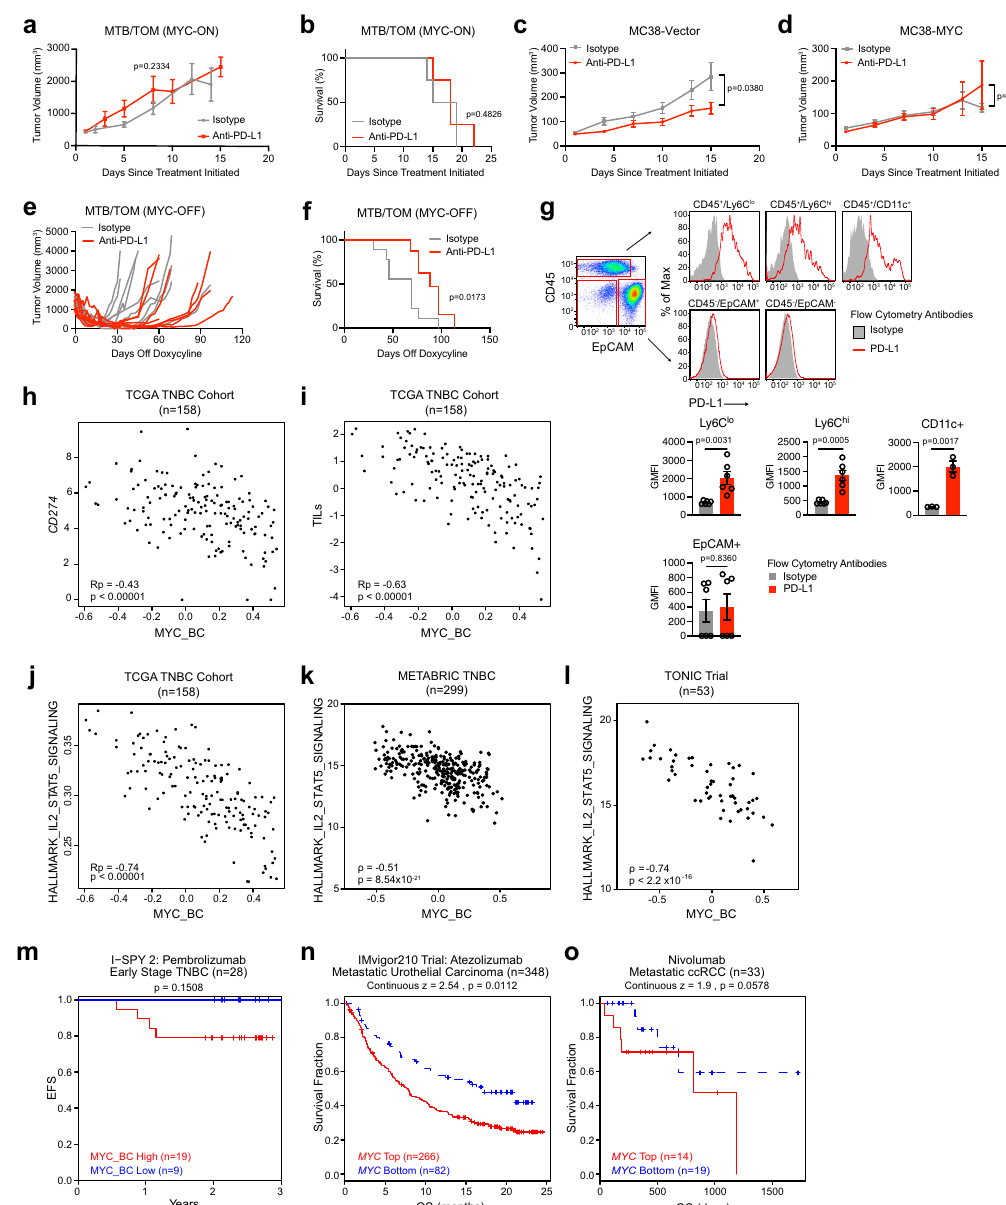
PH z-scores: n Kaplan – Meier curves of overall survival in patients with metastatic urothelial carcinoma from Mariathasan et al., 2018 and o Kapaln – Meier curves of overall survival in patients with metastatic clear cell renal cell carcinoma (ccRCC) from Miao et al., 2018. Source data are provided in the Source Data fi le. Source data for panel l provided at EGA